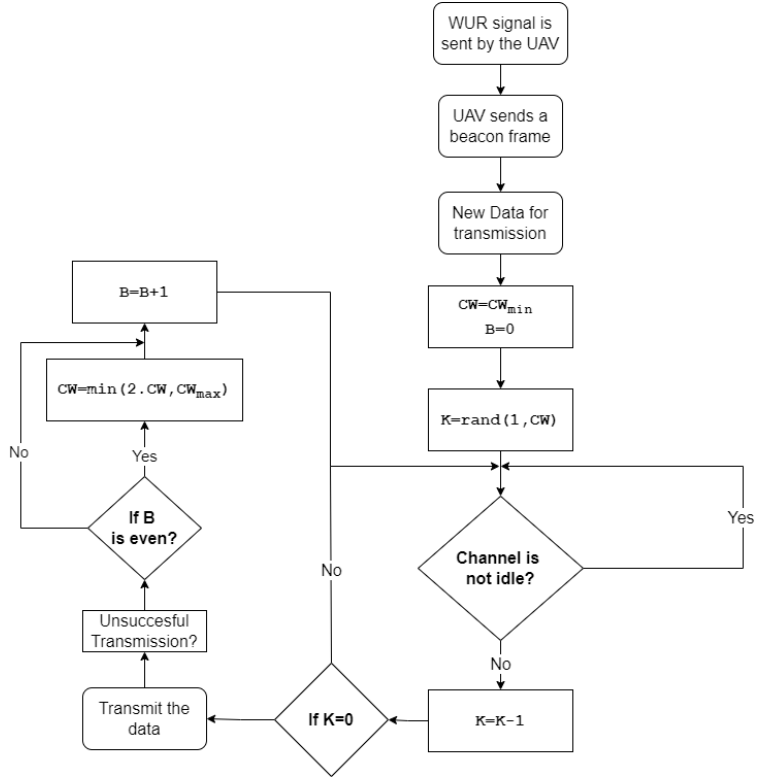
Figure 5. Schema of the suggested